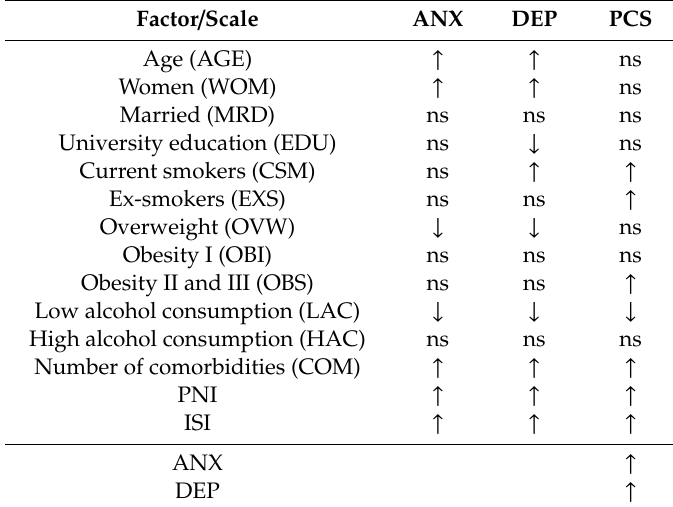
Table 4. Results of path analysis (direct e ff ects)-schematic